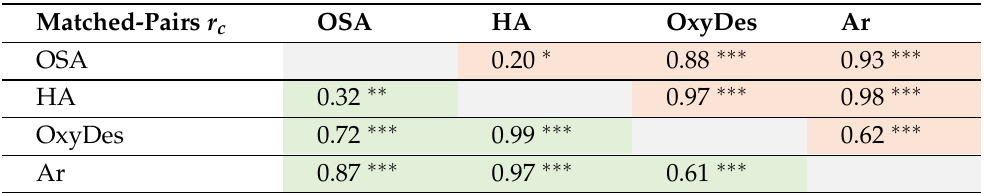
Table 2. The matched-pairs r c values of proportions of high-quality PPG between sleep-disordered breathing events obtained by using ECG-guided (orange background) and TM-based algorithms (green background), where OSA—obstructive sleep apnea, HA—hypopnea, OxyDes —oxygen desaturation, Ar—arousal events. p < 0.001 and r c < 0.30 is marked ∗ , p < 0.001 and r c ≥ 0.30— ∗∗ , p < 0.001 and r c ≥ 0.50— ∗∗∗ .